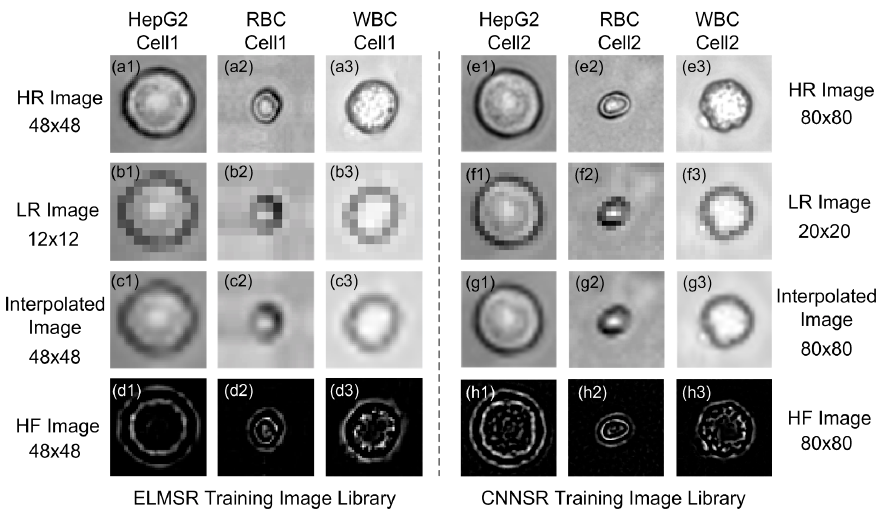
Figure 6. Example images of HepG2, Red blood cell (RBC), and white blood cell (WBC) in ELMSR and CNNSR training image libraries: ( a ) original high-resolution (HR) images with all high-frequency (HF) details in ELMSR library; ( b ) down-sampled low-resolution (LR) images with HF information lost in ELMSR library; ( c ) interpolated LR images whose HF cannot be recovered in ELMSR library; ( d ) HF components that are lost during downsampling in ELMSR library; ( e ) original HR images with all HF details in CNNSR library; ( f ) down-sampled LR images with HF information lost in CNNSR library; ( g ) interpolated LR images whose HF cannot be recovered in ELMSR library; and ( h ) HF components that are lost during down-sampling.